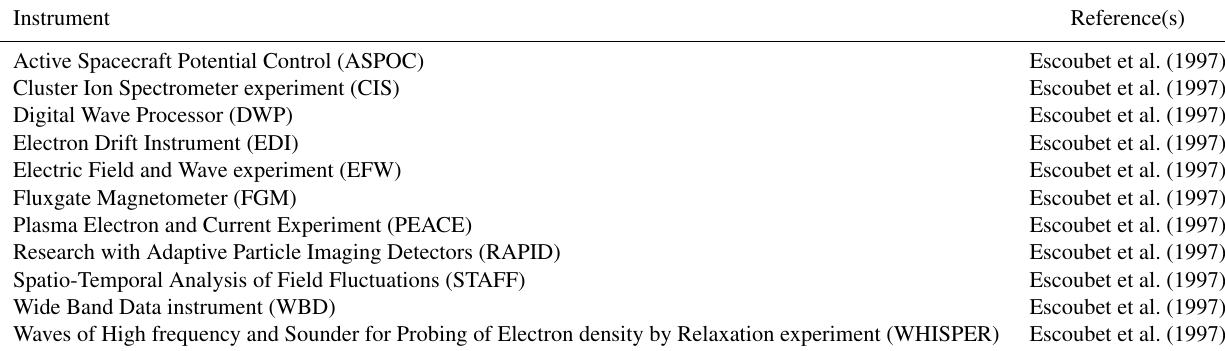
Table A4. Cluster’s instruments and references for team members lists.